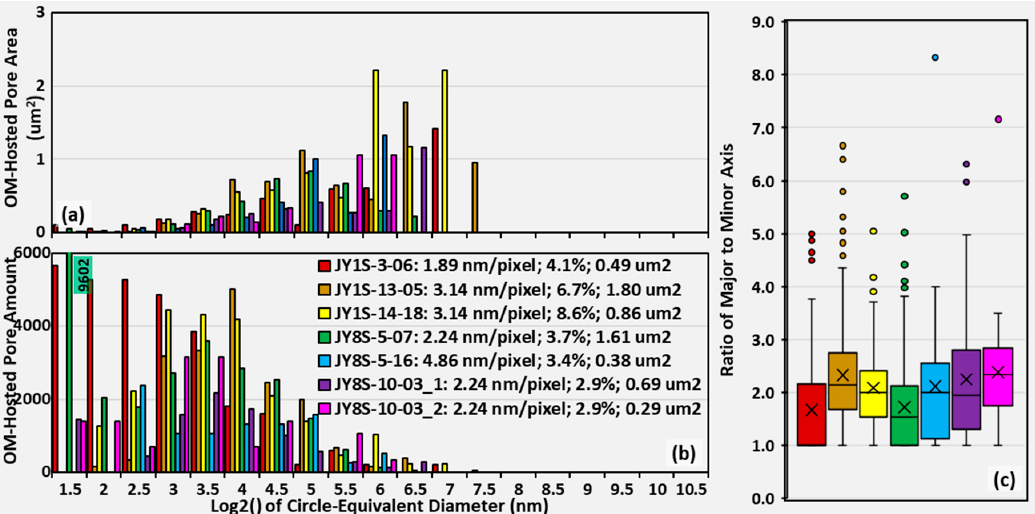
Figure 16. The pore size distribution (PSD) and geometry of OM-hosted pores within the third subtype of weakly or undeformed porous pyrobitumen (OM VI) of Longmaxi-Wufeng Shale, Eastern Sichuan Basin. ( a ) PSD determined by pore sectional area; and ( b ) PSD determined by pore amount; and ( c ) ratio of major to minor axis. The three values after image ID in the legend are image resolution (nm/pixel), organic porosity (%), and OM sectional area (µm 2 ). The number labels show the values that are beyond the range of the vertical axis.